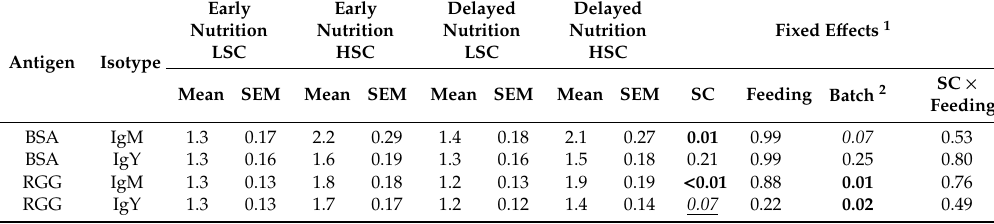
Table 3. Fold change (7 d relative to 0 d post immunization) of antibody titers (IgM, IgY) binding bovine serum albumin (BSA) or rabbit γ -globulin (RGG) in blood serum of broiler chickens fed with BSA during the first 3 d of age receiving delayed or early nutrition, kept under high (HSC) or low sanitary condition (LSC) in experiment II. Broilers were intratracheally immunized with BSA and RGG at 21 d of age, and bile was collected at 11 d post immunization. Data are presented as estimated marginal means with standard errors (SEM).